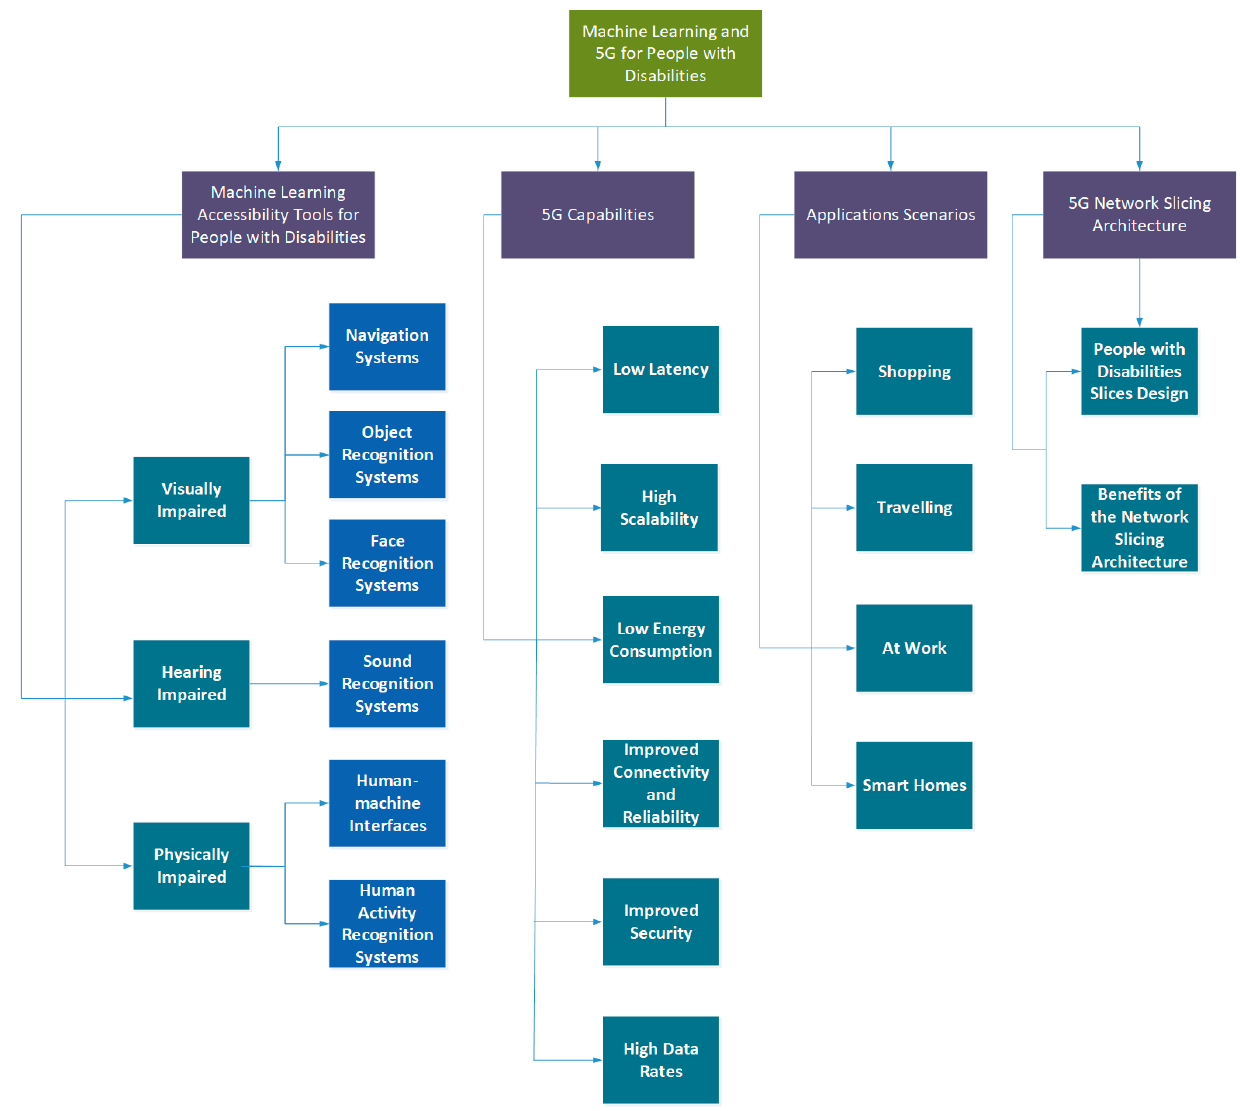
Figure 1. Proposed taxonomy of machine learning and 5G for people with disabilities.